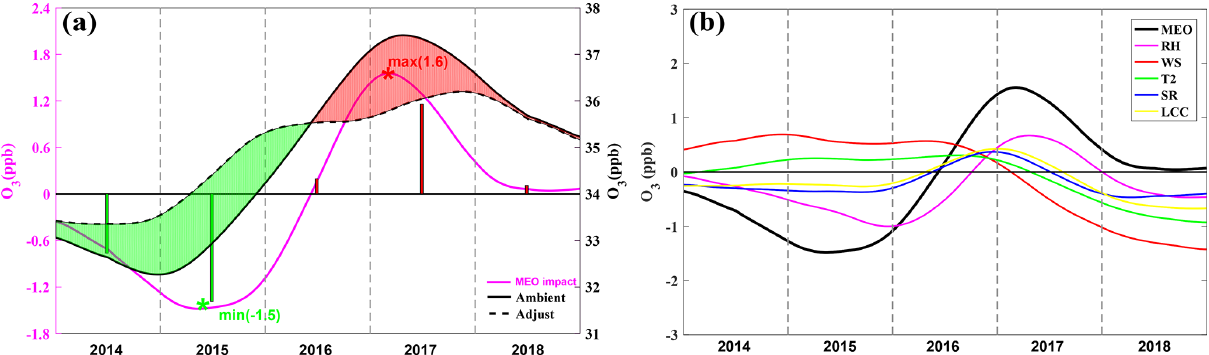
Figure 3. (a) The 5-year trends of ambient O 3 (solid black line), meteorological adjusted O 3 (dashed black line) and the meteorological impact (pink line) over the YRD during 2014–2018. Periods with positive and negative meteorological impacts are shaded in red and green, respectively; red and green bars represent the O 3 increases and decreases attributable to meteorological influences in each year. (b) The 5-year variations in the meteorological impact of different meteorological factors (MEO), including relative humidity (RH), solar radiation (SR), air temperature (T2), wind speed (WS) and low cloud cover (LCC).